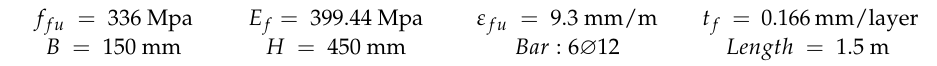
Table 2. Geometrical and strength specifications of the columns studied by Rahaee and Akbarpour [2].